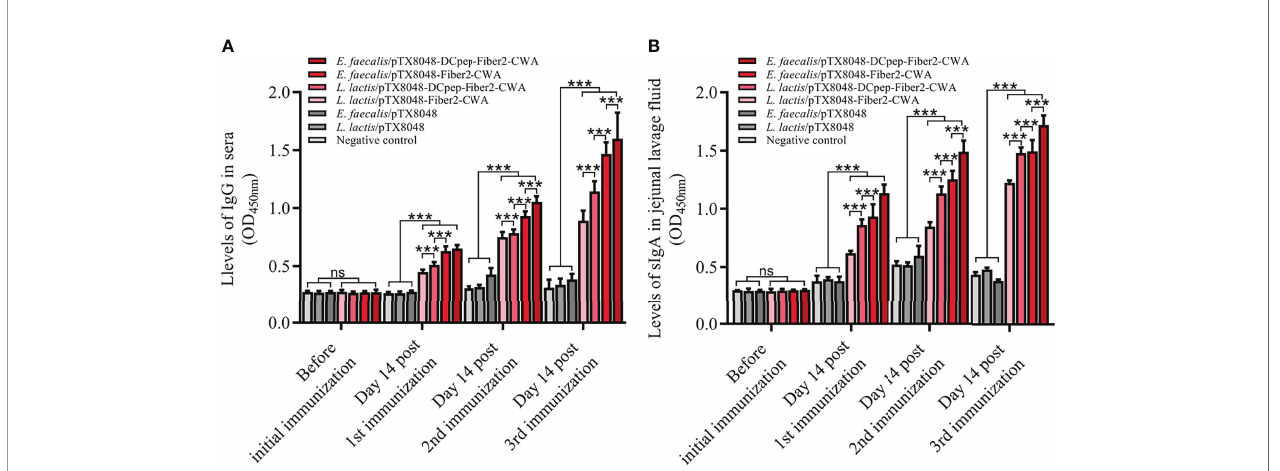
FIGURE 4 | The levels of IgG and sIgA evoked by live recombinant probiotics at each time point. Before the fi rst immunization and at 2 weeks after each immunization, serum samples from chickens (n = 5) in each group were prepared. rFiber2 protein was used to coat the 96-well plate. One hundred-fold diluted experimental chicken sera or 50-fold diluted jejunal lavage fl uid was applied as primary antibody to react with coated rFiber2 protein, respectively. The IgG antibody level in sera (A) and sIgA antibody level in jejunal lavage fl uid (B) were analyzed. Data are expressed as mean ± SD. ns means p > 0.05, *** p < 0.001.